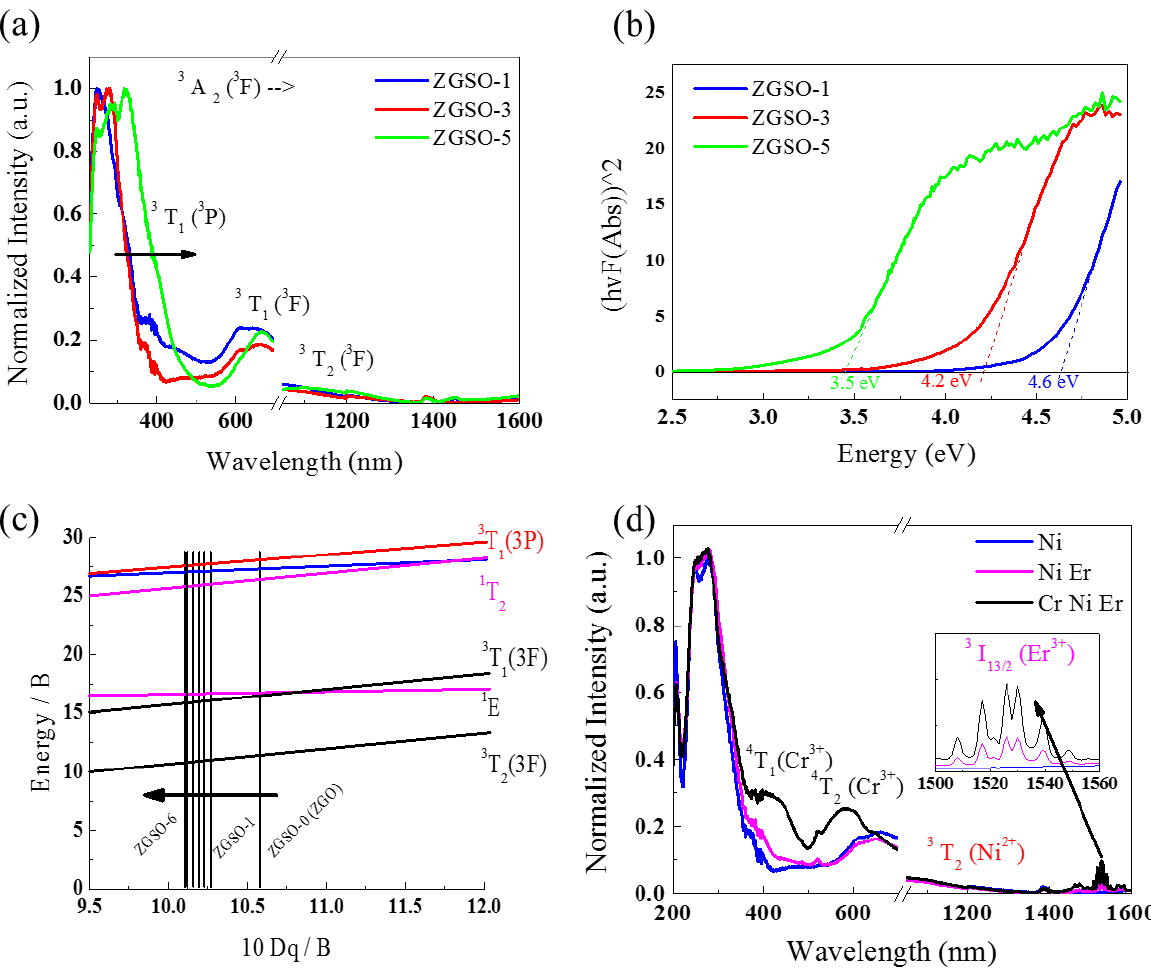
Figure 2. ( a ) Normalized absorption spectra of samples Ni 2+ -doped ZGSO-1 (Zn 1.1 Ga 1.79 Ni 0.01 Sn 0.1 O 3.995 ), ZGSO-3 (Zn 1.3 Ga 1.39 Ni 0.01 Sn 0.3 O 3.995 ), and ZGSO-5 (Zn 1.5 Ga 0.09 Ni 0.01 Sn 0.5 O 3.995 ). ( b ) Bandgap calculation of samples Ni 2+ -doped ZGSO-1, ZGSO-3, and ZGSO-5. ( c ) Part of the Tanabe–Sugano diagram of Ni 2+ with d 8 electron configuration in the complex spinel samples of ZGSO-0~ZGSO-6 with different Sn concentrations (see Table S3). ( d ) Transition-metal (Ni 2+ and/or Cr 3+ ) and rare-earth (Er 3+ ) doped ZGSO-3. The illustration is a partial enlargement of Er 3+ absorption.